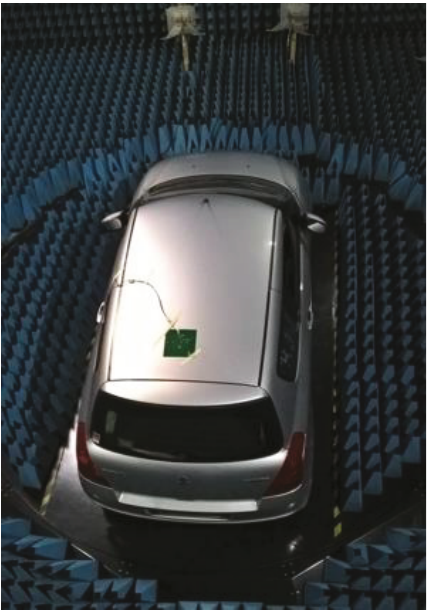
Figure 14: Photo of the measurement for DRA implement on the vehicle